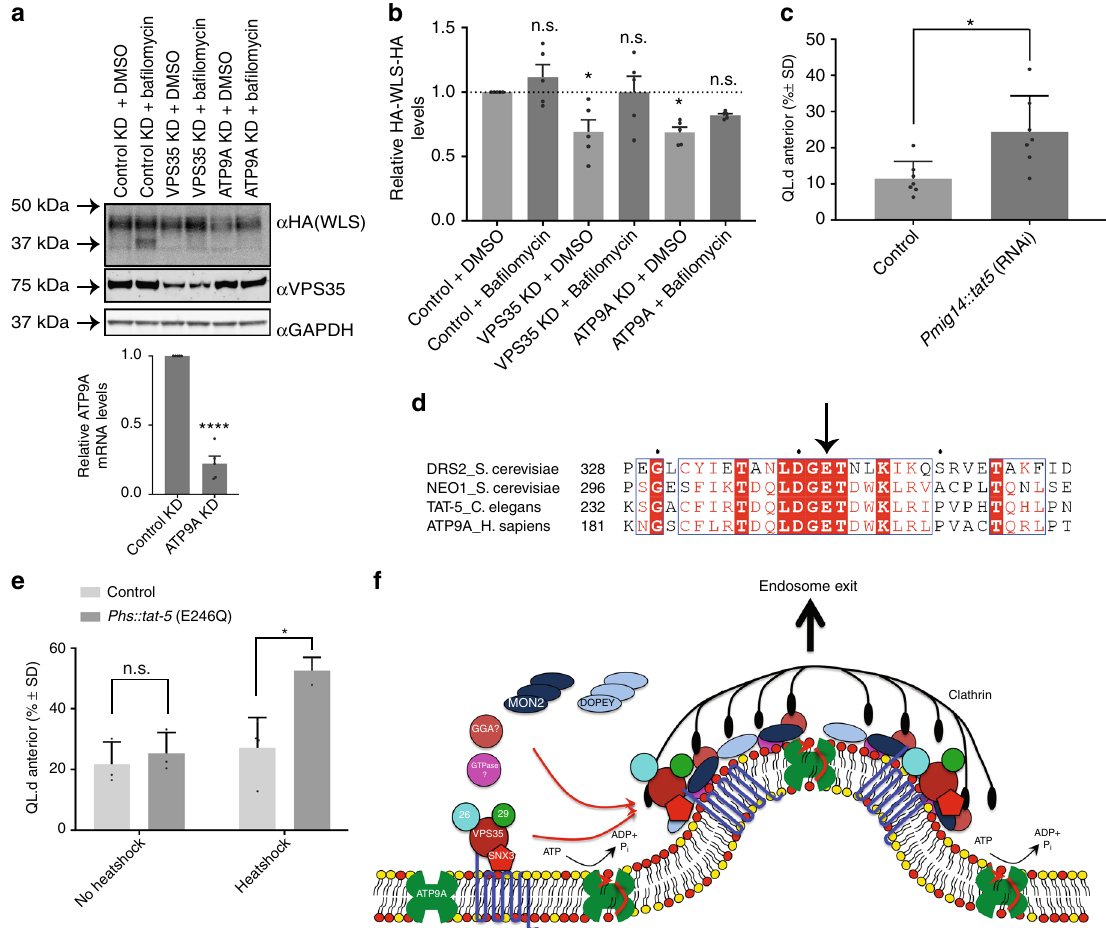
Fig. 5 ATP9A is required for Wls sorting and is required for Wnt gradient formation. a RPE-1 cells, stably expressing HA-WLS, under RNAi-mediated suppression of VPS35 or ATP9A were treated with Ba fi lomycin A1 (100 nM for 16 h). Knock-down of ATP9A was con fi rmed through RT-qPCR. b Quanti fi cation of HA-WLS protein levels reveal a similar loss of HA-WLS through VPS35 or ATP9A suppression that is reverted upon blocking of lysosomal-mediated degradation using Ba fi lomycin A1. Data presented as mean + / − s.e.m. from fi ve independent biological replicates. Signi fi cance was determined using a one-way ANOVA followed by a post-hoc Dunnett ’ s test; * p < 0.05. c Tissue speci fi c RNAi of tat-5 in Wnt producing cells ( Pmig-14::tat-5 RNAi) in a vps-29(tm1320) sensitised mutant background. The percentage of animals with anteriorly displaced QL.d is shown (data are presented as mean + / − SD and include results from seven independent biological replicates, n ≥ 24 per replicate) * p = 0.013 (Student ’ s t -test). d Sequence alignment of Drs2p with Neo1p homologues highlighting the conserved catalytic glutamic acid residue essential for ATPase activity. e Overexpression of catalytically inactive TAT-5(E246Q) in a vps-29(tm1320) sensitised mutant background. The percentage of animals with anteriorly displaced QL.d is shown (data are presented as mean + / − SD and include results from three independent biological replicates, n ≥ 30 per replicate) * p = 0.0089 (Student ’ s t -test). f Schematic representation of our working model: SNX3-retromer, coupled to MON2/DOPEY2, enriches Wntless into nascent carriers, formed through the fl ippase activity of